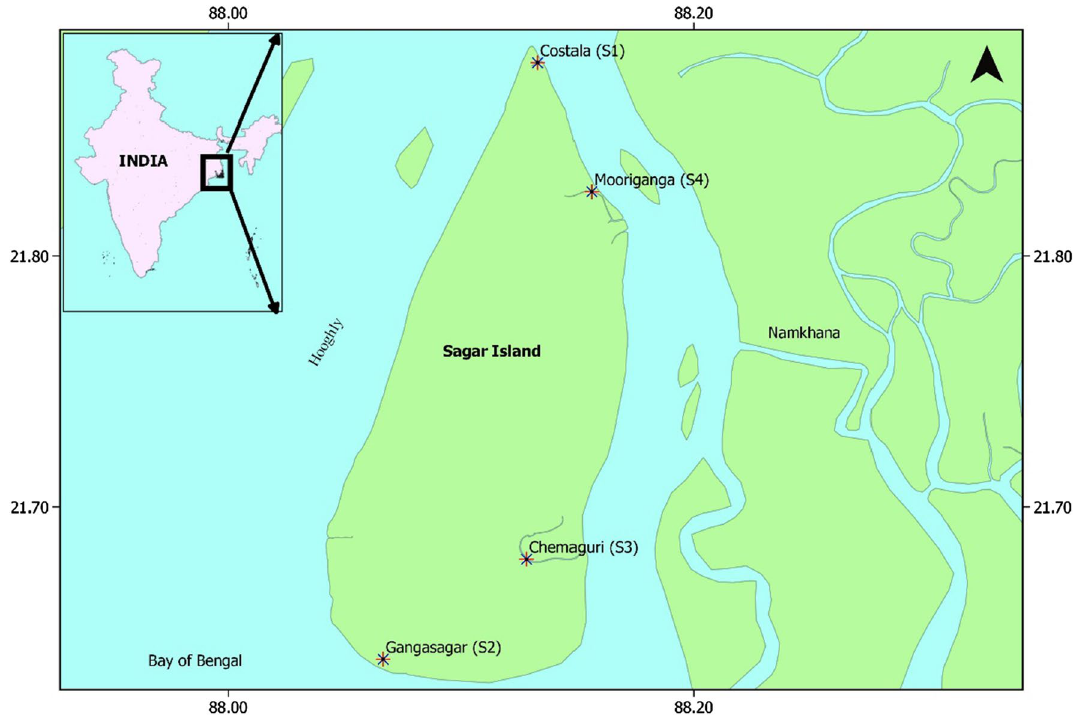
Fig. 1 The map showing the geographical locations of the sampling sites and study area in Sagar Island,